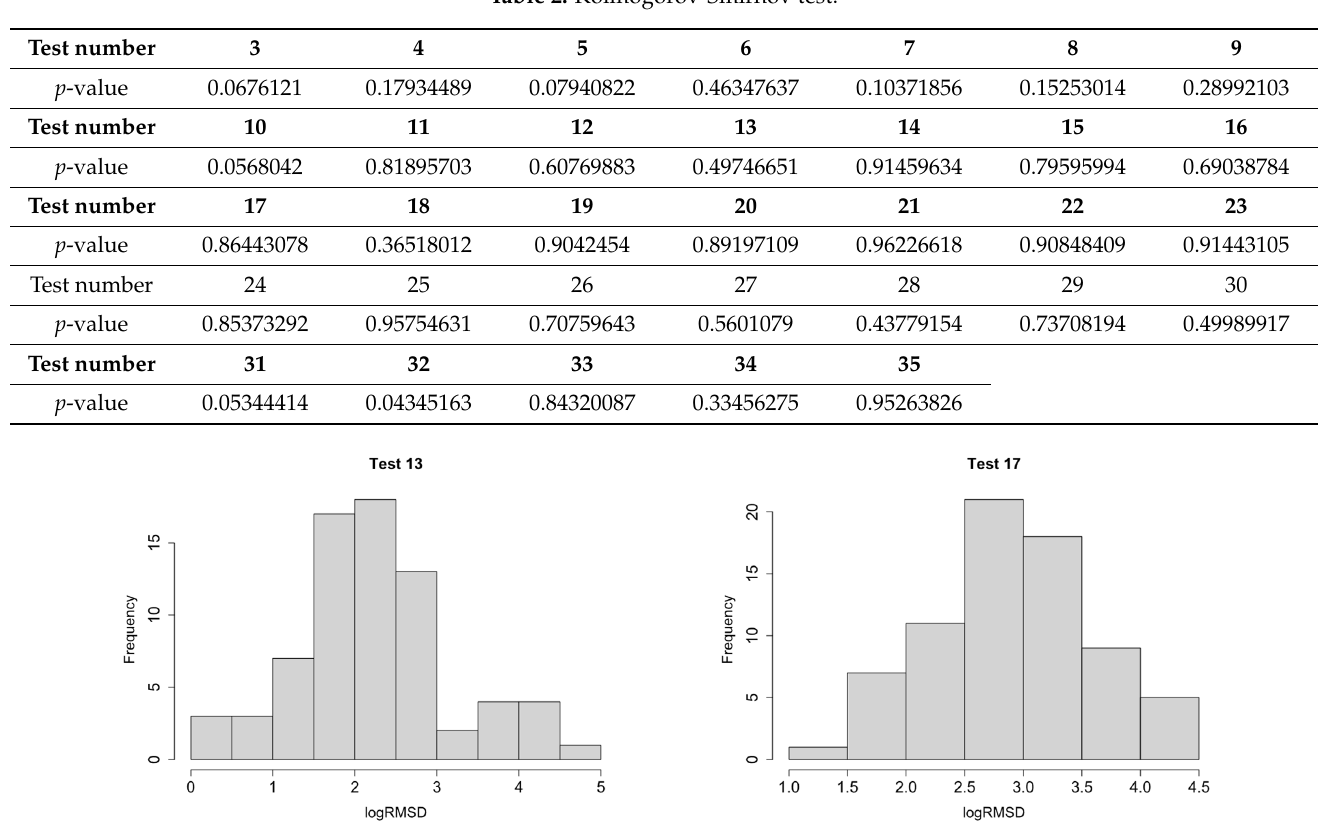
Figure 8. logRMSD histograms.